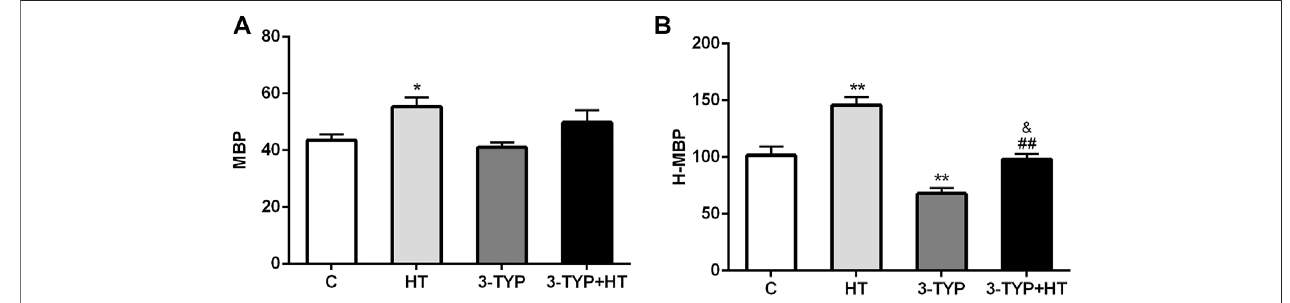
FIGURE1| Changesofskin and skeletal muscle microcirculation after Sirt3inhibition and hypoxic training interventions. (A) Were comparisons ofmicrocirculatory blood perfusionafter interventions (MBP). (B) Were comparisonsofheatedmicrocirculatory blood perfusion after interventions(H-MBP). Ccontrol;HT, hypoxic training; 3-TYP, Sirt3 inhibitor 3-TYP; 3-TYP + HT, 3-TYP + hypoxic training. n = 6 * p < 0.05, ** p < 0.01 vs. C; ## p < 0.01 vs. HT; and p < 0.05 vs. 3-TYP. All the results were presented as mean ± SEM.